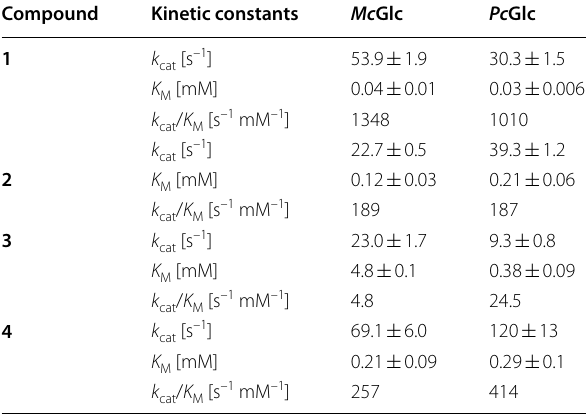
Table 1 Kinetic constants for the hydrolysis of compounds 1 – 4 using Mc Glc or Pc Glc as a catalyst Compound